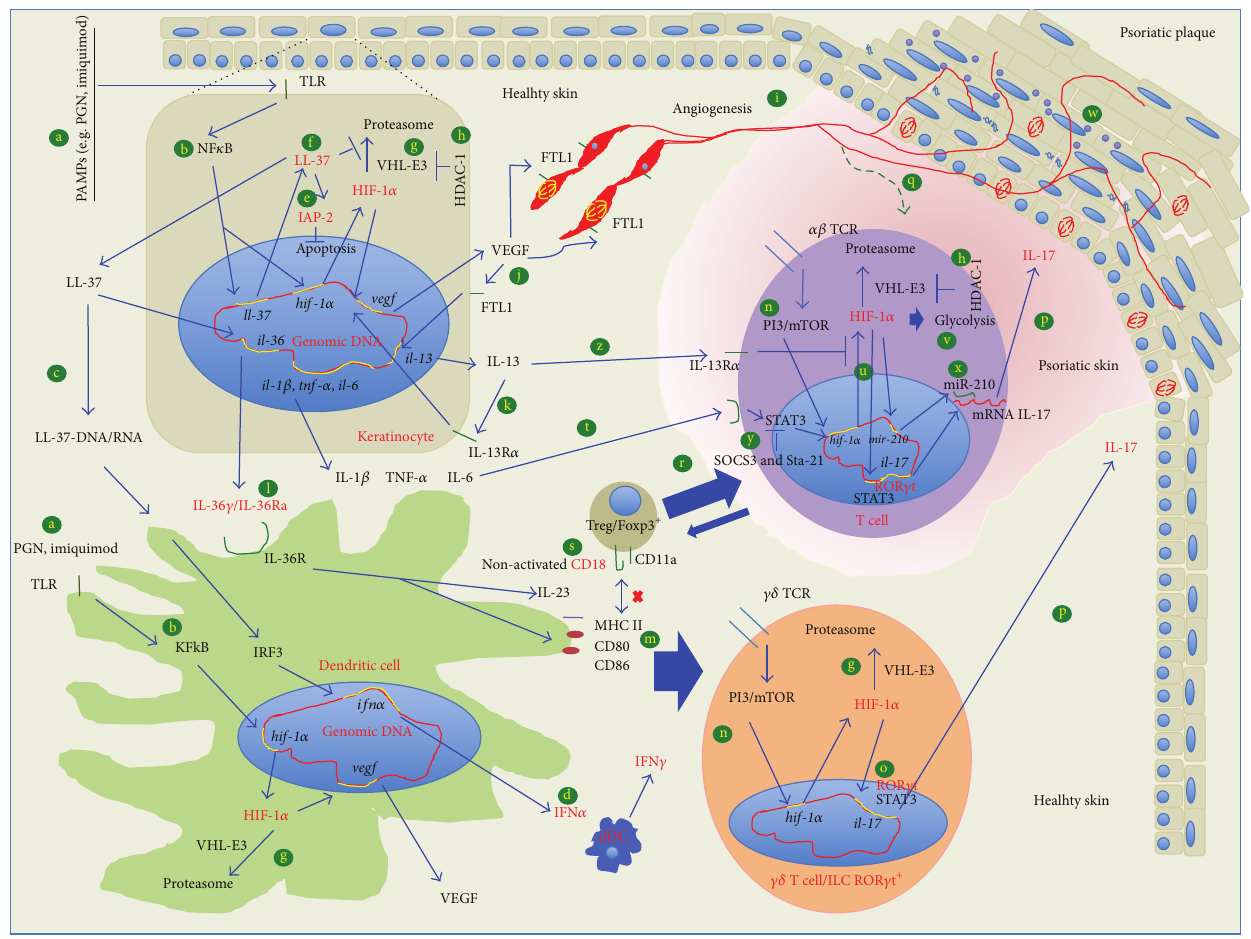
Figure 1: Hypotetical interaction between the keratinocyte and cells from immunologycal system and role of HIF-1 𝛼 , in the generation of a psoriatic lesions. The following mechanism of epidermal response proposed occurs in healthy individuals. But, in psoriatic patients, this mechanism could generate psoriatic lession, because they might have impaired genes involved in the immune homeostasis (pink zone corresponds to psoriatic skin). When virus, bacteria or a fisical factor interacts with epithelial cells, (a) NF 𝜅 B is activated via TLR (b) and translocated to nucleus to induce LL-37 and HIF-1 𝛼 expression. The released LL-37, together with DNA or RNA (c), activates plasmacytoid dendritic cells to produce IFN 𝛼 and induce the activation of Th17 via IFN 𝛾 (d). On the other hand, intracellular LL-37 favors proliferation of keratinocytes inducing IAP-2 expression (e); besides, intracellular LL-37 also facilitates angiogenesis inhibiting the proteosomal degradation of HIF-1 𝛼 (f) driven by E3/VHL (g) which is downregulated by HDAC-1 (h). After HIF-1 𝛼 is stabilized by LL-37, HIF-1 𝛼 is translocated to the nucleous to induce VEGF expression, that is, a potent angiogenic factor (i). The concentrations of VEGF also augment in a feedback manner with IL-13/IL-13R system in keratinocytes (j and k). The released LL-37 is also considered as an alarmin that is able to induce IL-36 production (l) which in turn activates dendritic cells and induce IL-23 production (m). The dendritic cells activate 𝛾𝛿 -T cells and ILC (both ROR 𝛾 t + ) located in the healthy dermal epithelium to trigger the production of IL-17 through PI3/mTOR-HIF-1 𝛼 -ROR 𝛾 t (n, o, and p). The reclusion of Th17 cells is facilitated by the angiogenesis and chemiotatactic molecules in the psoriatic lession (q) and also Th17 could derive from Treg with nonfuntional CD18 (r and s) to produce even more IL-17 (p) via IL-6-Stat3-HIF-1 𝛼 -ROR 𝛾 t (t, u, and p) in an activated glycolisys (v). IL-17 induces keratinocytes proliferation (w). Some targets proposed for the treatment for psoriasis are shown. The use of miR-210 (x), the use of STAT3 inhibitors: SOCS3 and Sta-21, (y) the downexpression of VHL (g), and the high expression of IL-13R 𝛼